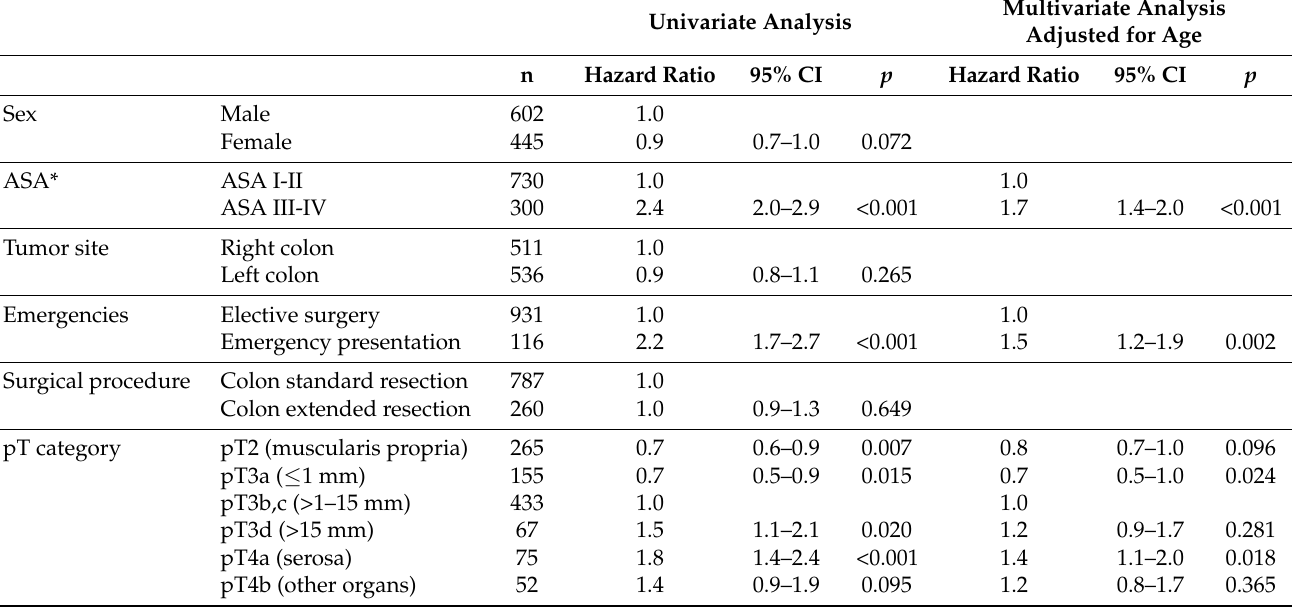
Table 6. Disease-free survival, multivariate Cox regression analysis (n =